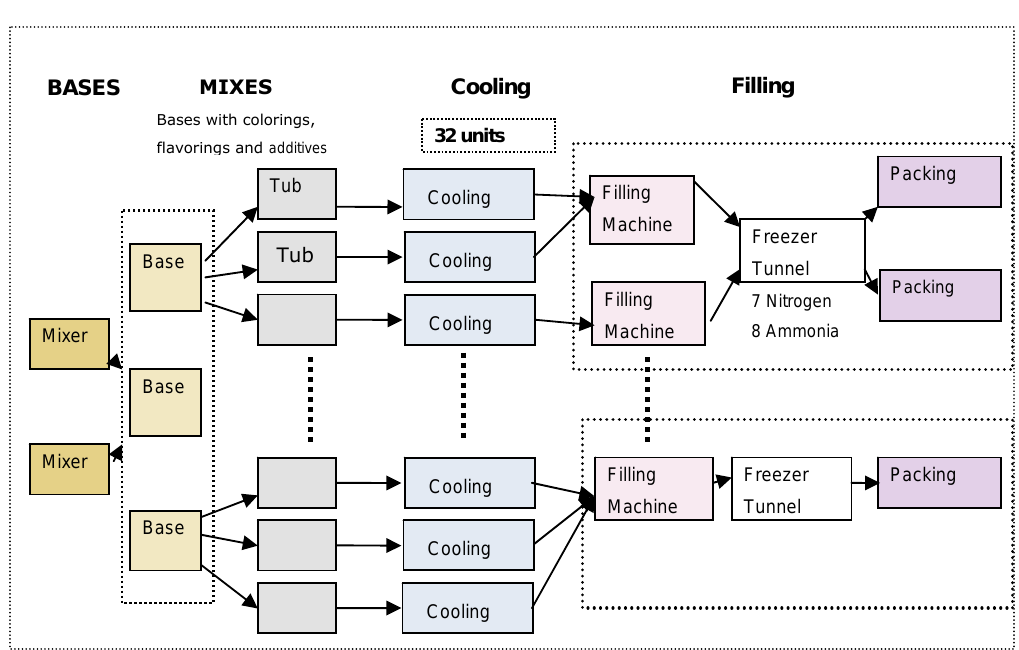
Figure 1. “Work-flow of the production system”. Source: